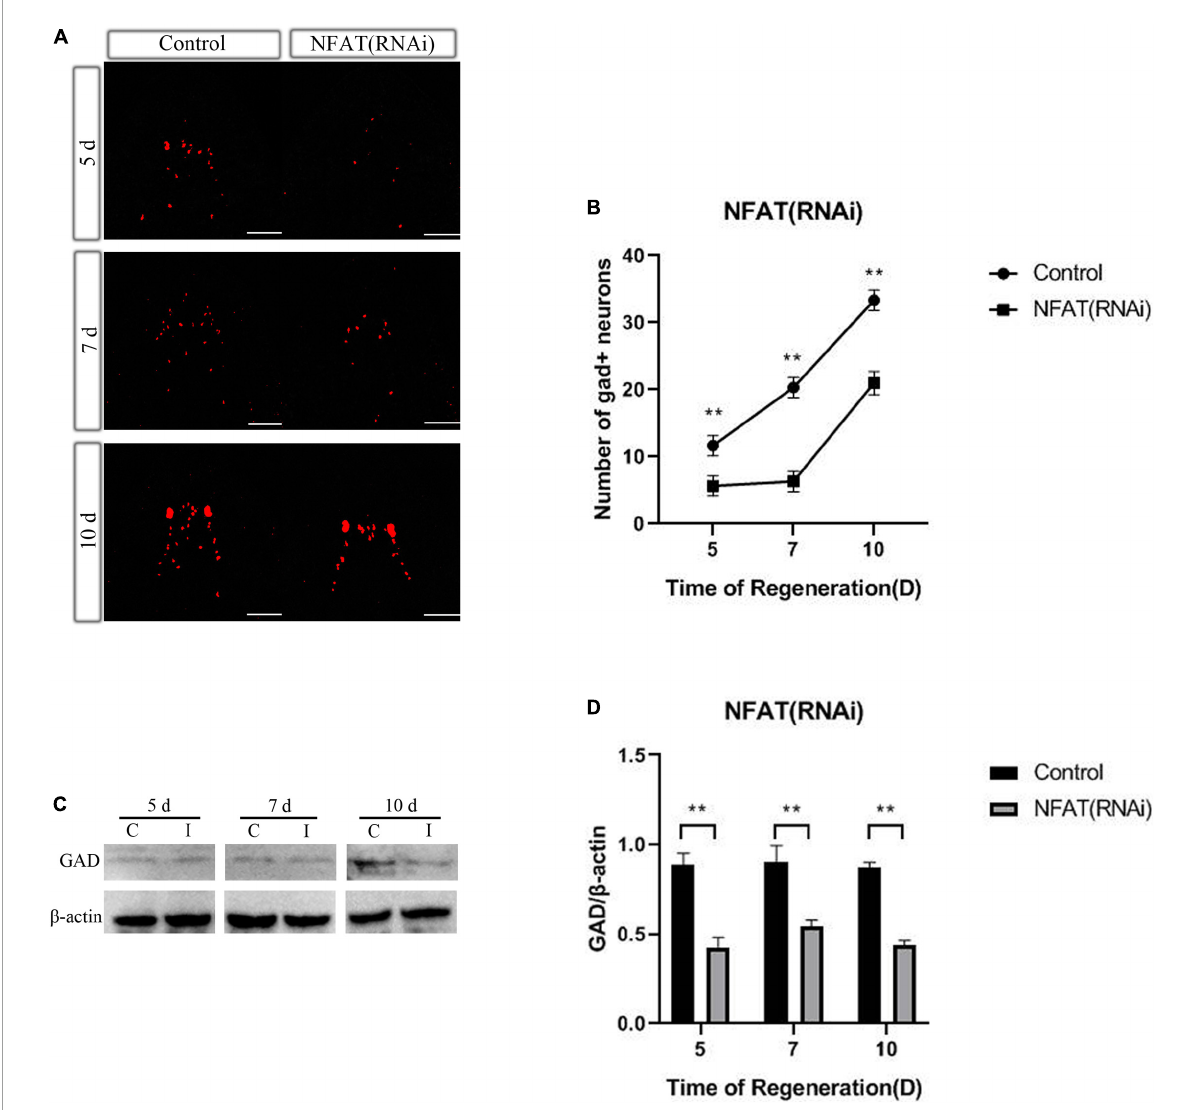
FIGURE7 DjNFAT inhibition influences the number of GABAergic neurons during planarian head regeneration. (A) FISH showing the expression of DjGAD in regenerating planarians at 5, 7, and 10 days after amputation, n = 5. Scale bars: 0.2 mm. (B) The number of DjGAD-expressing neurons. Error bars represent the SD (** P < 0.01). Anterior is at the front. d, day. (C) Western blotting results of DjGAD protein expression in the regenerated head of control and DjNFAT-RNAi planarians, n = 4. (D) The expression levels of GAD protein in regenerated planarians. C, control; I, DjNFAT